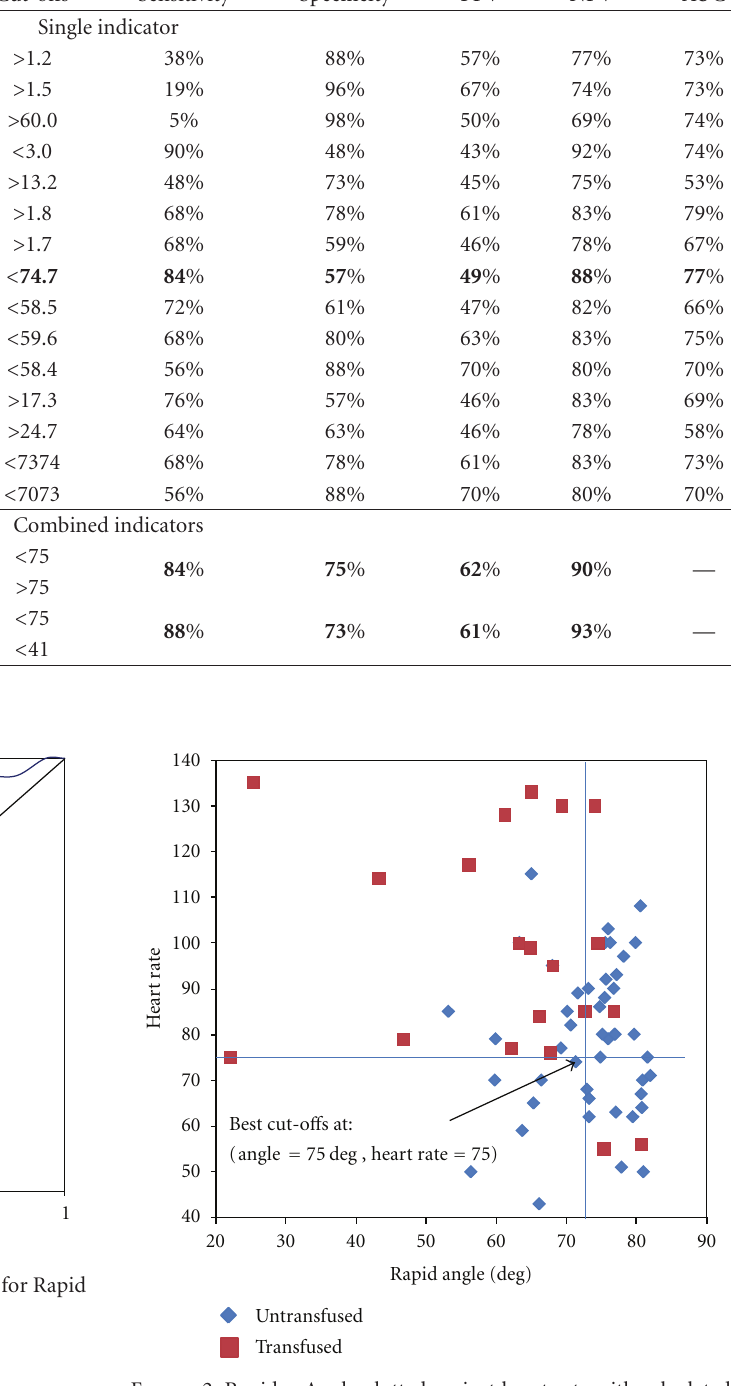
Figure 2: Rapid α -Angle plotted against heart rate with calculated cuto ff values. transfusion would receive one. Combining the Rapid TEG α -Angle (coagulation indicator) with a clinical sign (heart rate) or other point-of-care test (haematocrit) improves the di ff erentiation of patients who require transfusion from those who do